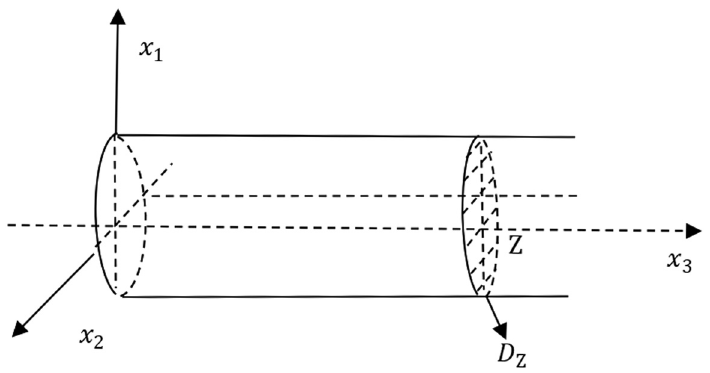
Figure 1: Cylindrical